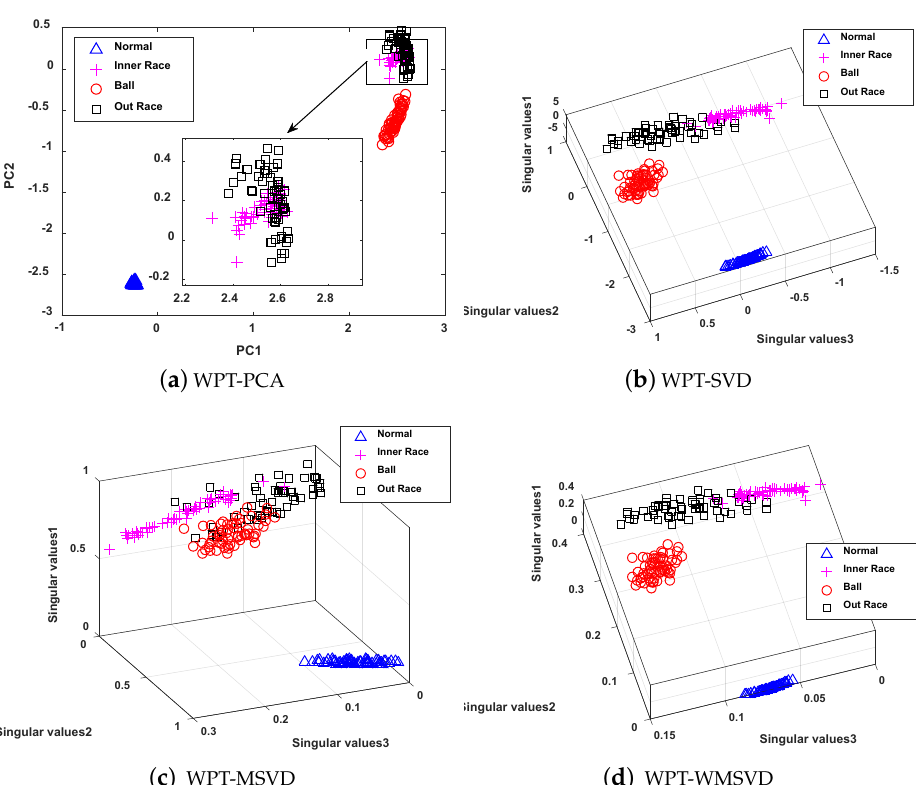
Figure 19. The Visualization of feature extraction effect of four methods under serious faults: ( a ) Dis- tribution of the data samples based on WPT-PCA; ( b ) Distribution of the data samples based on WPT-SVD; ( c ) Distribution of the data samples based on WPT-WSVD; ( d ) Distribution of the data samples based on